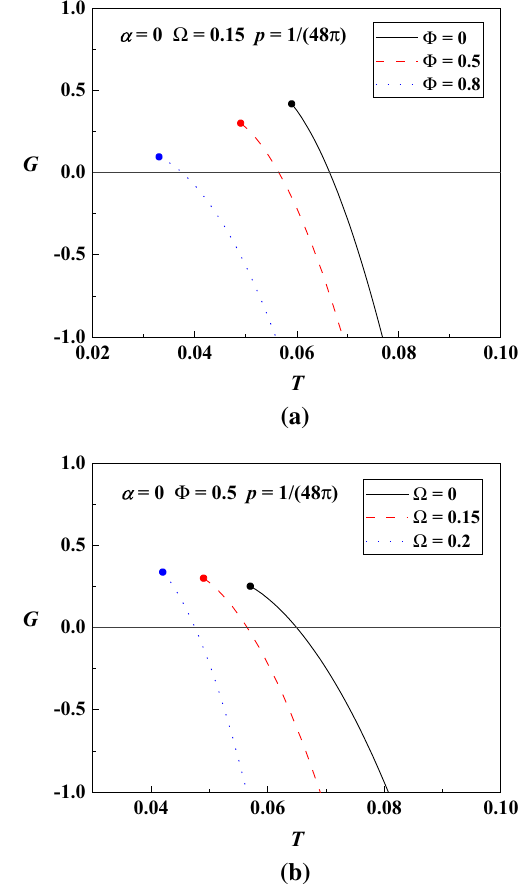
Fig. 11 The Gibbs free energy of large KN–AdS black holes as a func- tion of temperature, with pressure p = 1 /( 48 π) . T HP decreases with both Φ and Ω , with the detailed values of Φ and Ω listed in each panel.